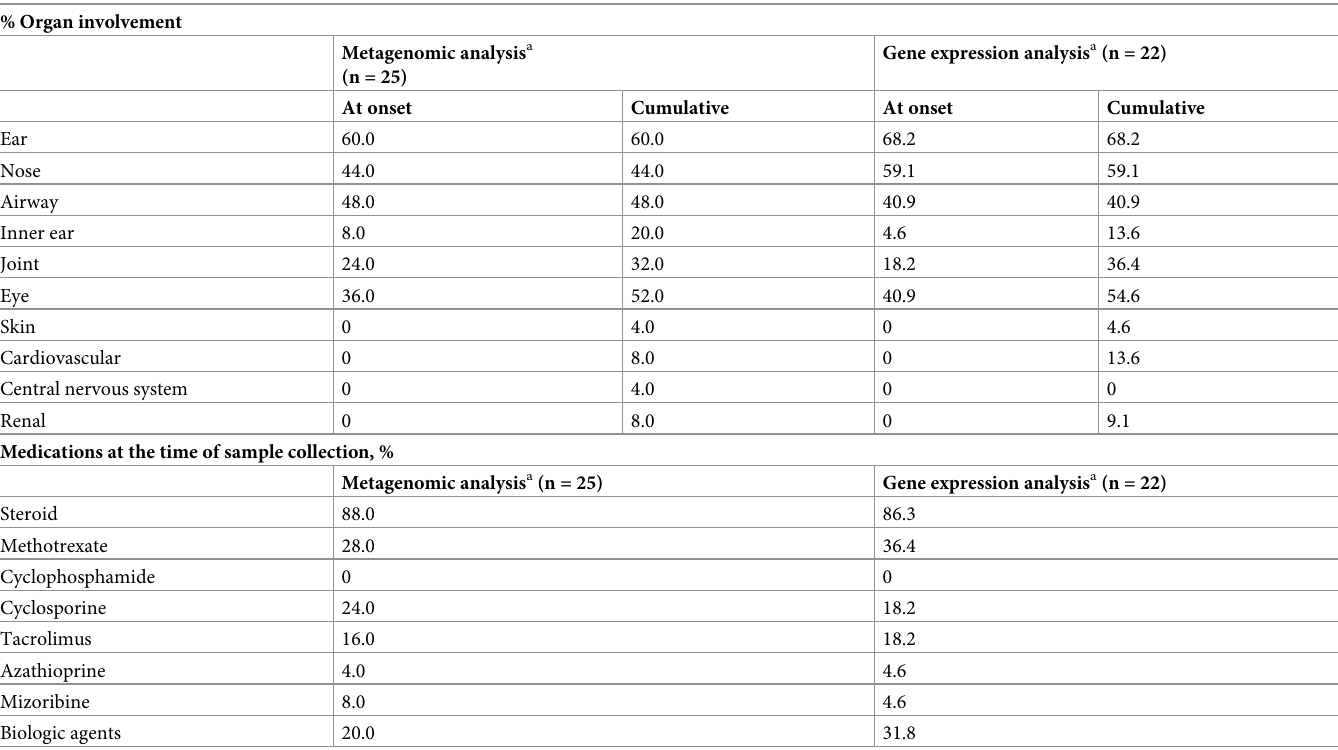
Table 1. Clinical characteristics of patients with relapsing